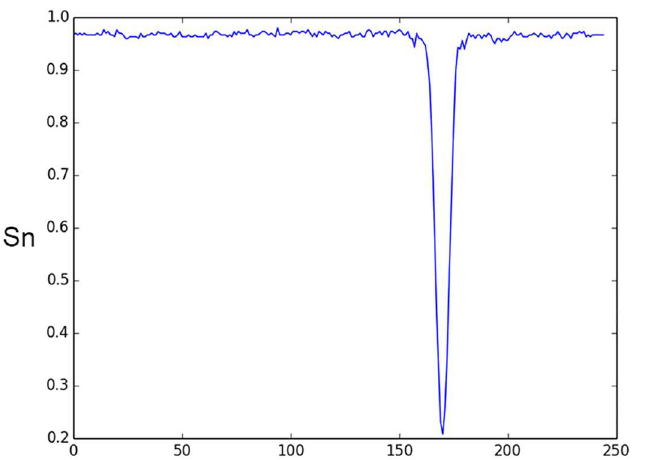
Fig 3. Effect of 6-nt sequence window substitution by randomsequence on accuracyof classification of human TATA promoters. X-axis is the windowposition,Y-axis is promoteridentificationsensitivity after a